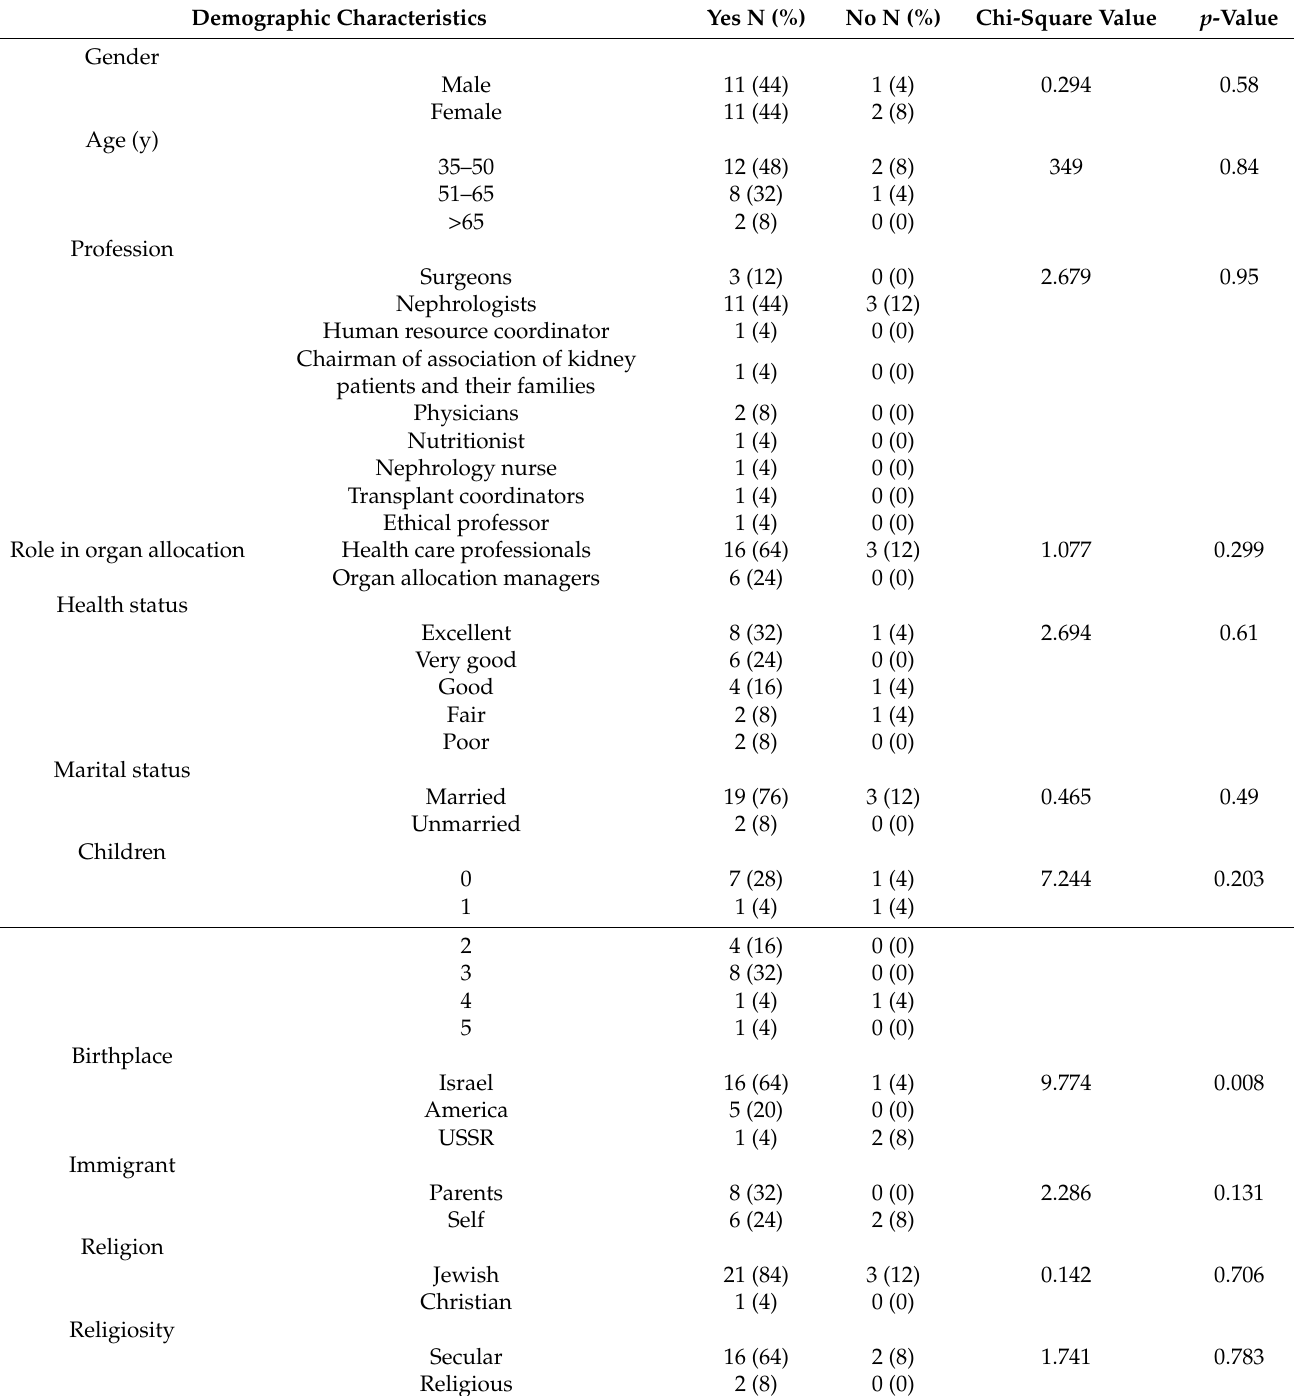
Table 2. Comparison of demographic data with registered organ